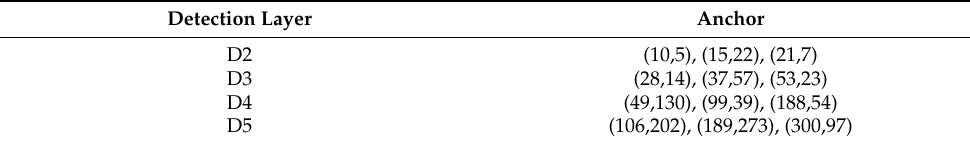
Table 5. Anchor of each detect head.